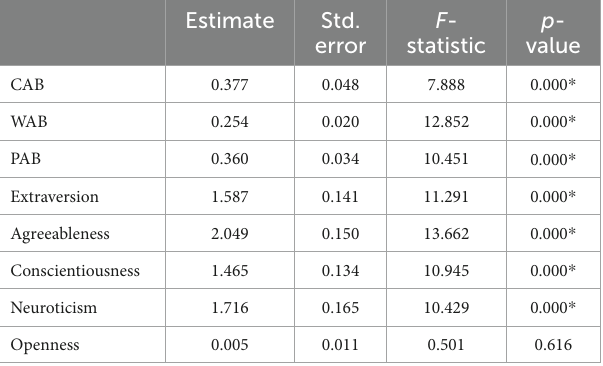
TABLE 4 Analysis of variance of latent extracted variables of the combined model BOSSm18 and